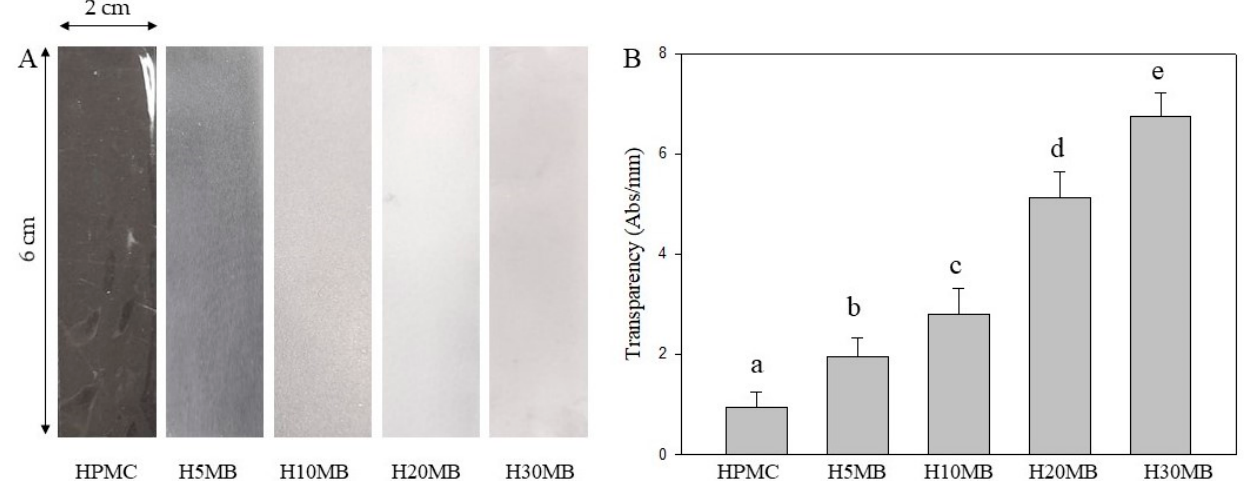
Figure 2. Image ( A ) and transparency values ( B ) of the hydroxypropyl methylcellulose (HPMC), 5% microcrystalline cellulose (MCC) (H5MB), 10% MCC (H10MB), 20% MCC (H20MB), and 30% MCC (H30MB) films. a–e letters indicate significant differences ( p < 0.05).